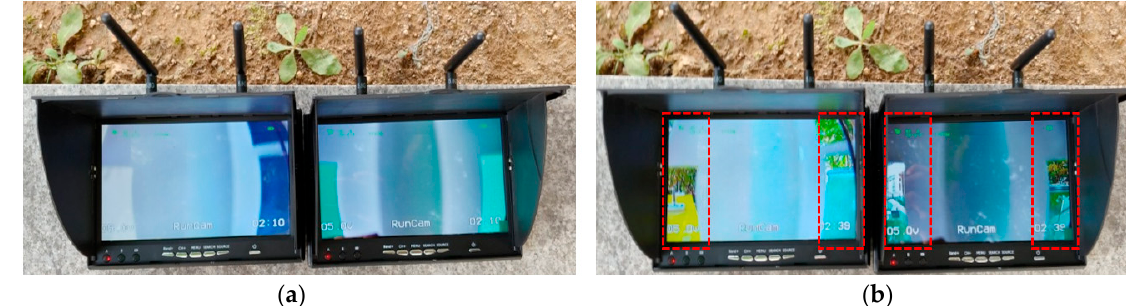
Figure 12. Images captured by the onboard cameras of the CanSat ( a ) before and ( b ) after deployment of the solar panels.